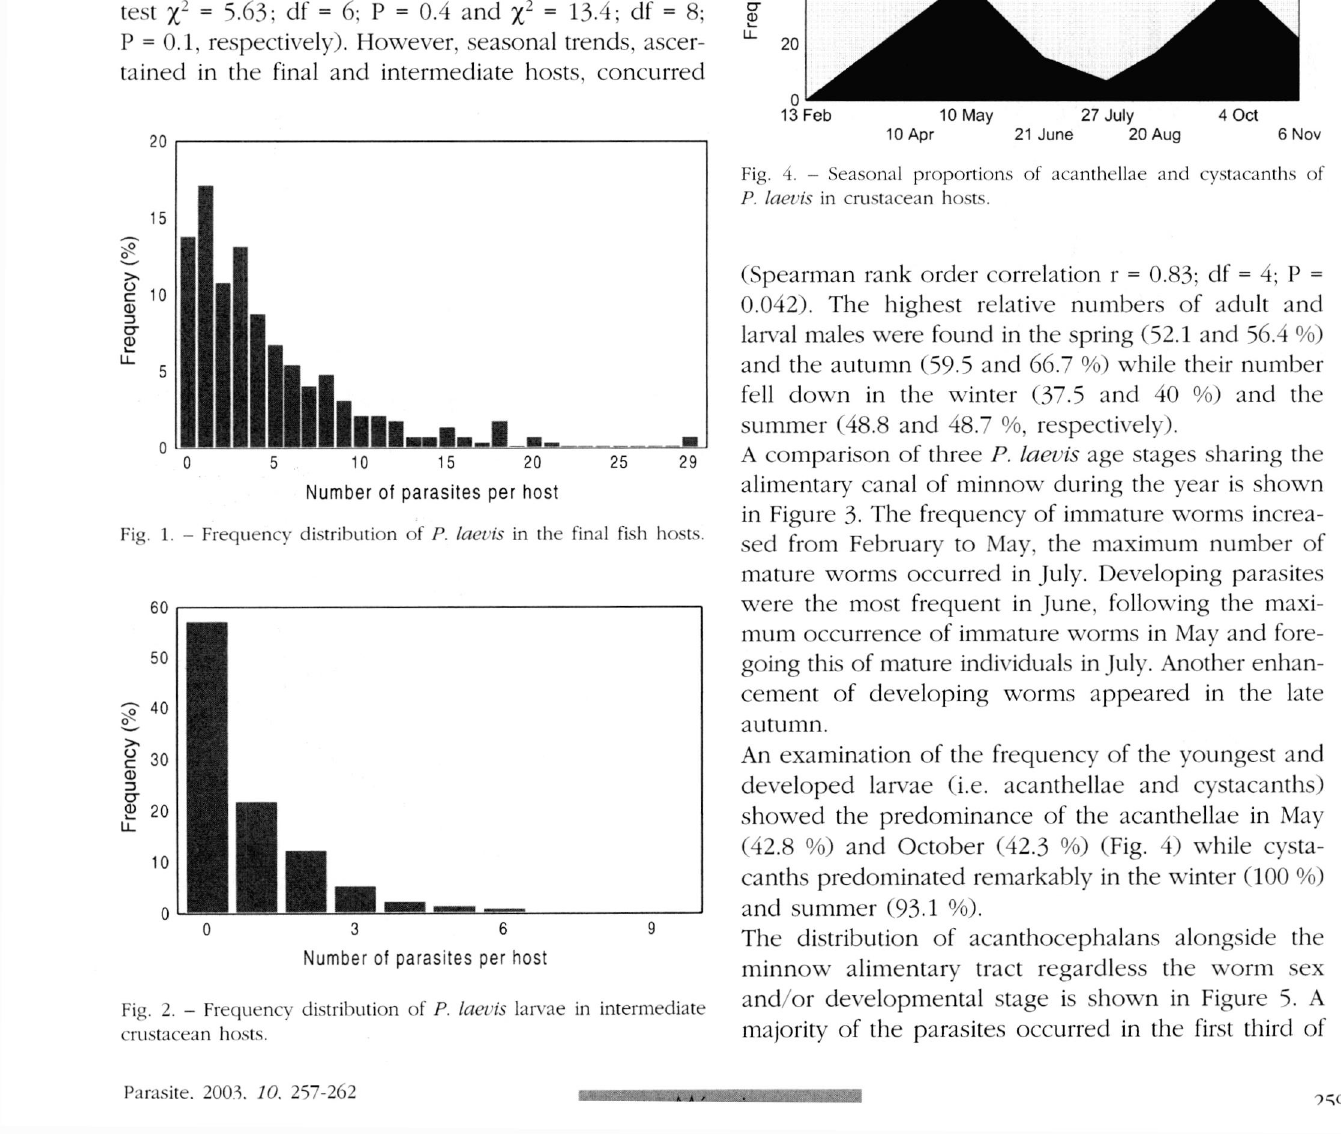
Fig. 4. - Seasonal proportions of acanthellae and cystacanths of P. laevis in crustacean hosts.